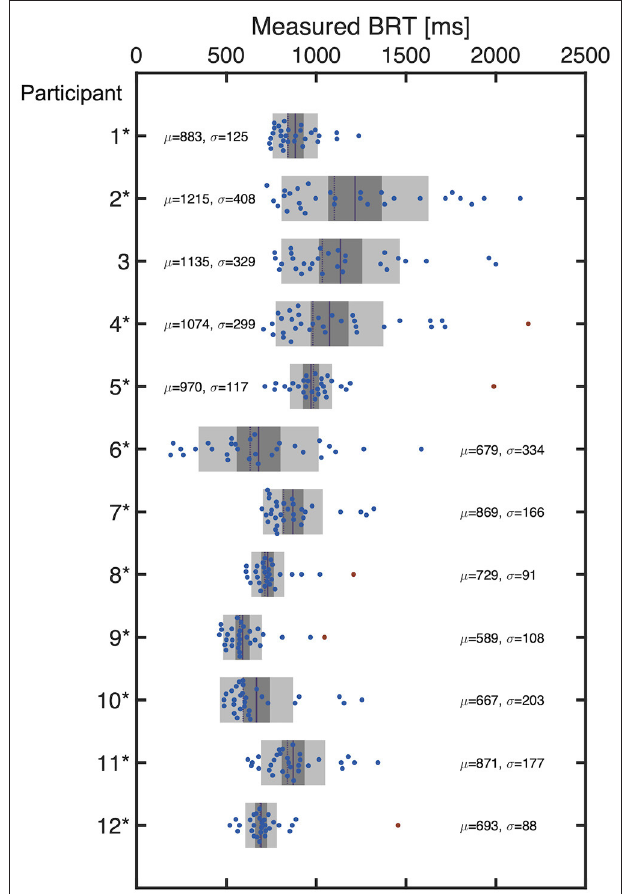
FIGURE 4 | The distribution of BRT measured for each participant. The red dots indicate the outliers excluded from the regression modeling. The mean ( µ ) and standard deviation ( σ ) are also indicated for each